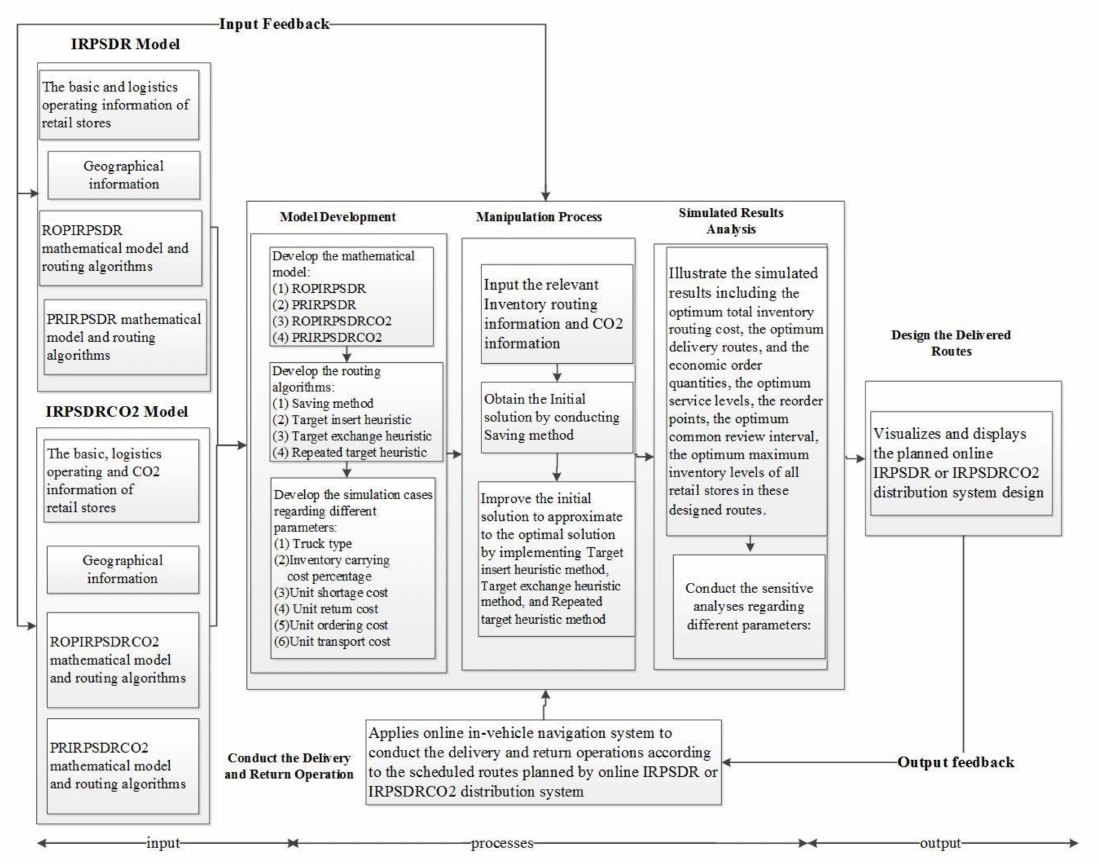
Figure 2. The procedure flow of online IRPSDRCO 2 distribution